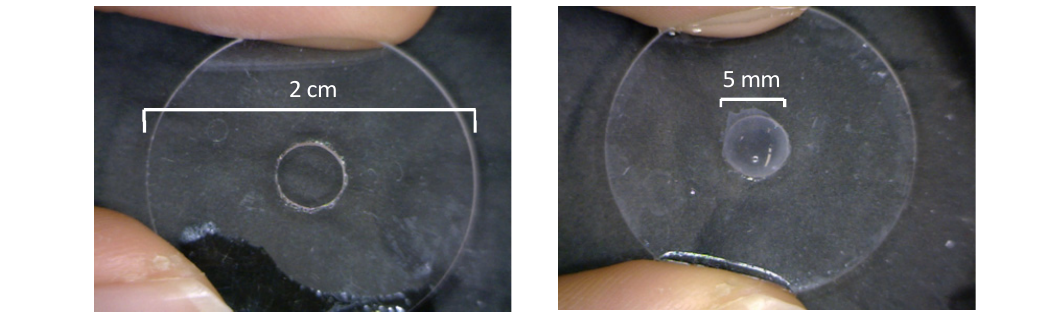
Figure 3. Photographs of a glass disk with a 5 mm aperture ( a ) before and ( b ) after film (PAH-PSS) 5